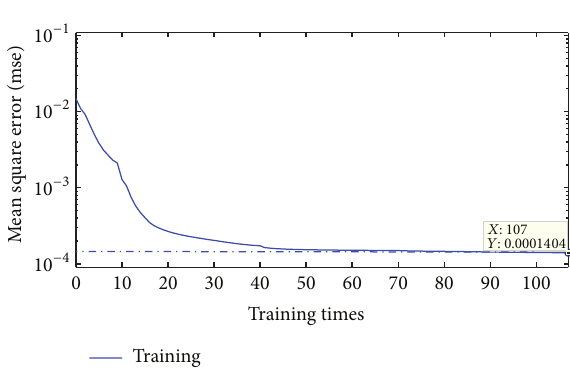
particle had four dimensions, representing the four elastic moduli of the rock masses. When the fitness function reached moduli of the rock masses in the right bank slope ( 𝐸 1 , 𝐸 2 , 𝐸 𝐸 3 , and 4 ) were obtained. The results showed that they were 0.45 GPa, 2.50 GPa, 2.76 GPa, and 7.98 GPa,